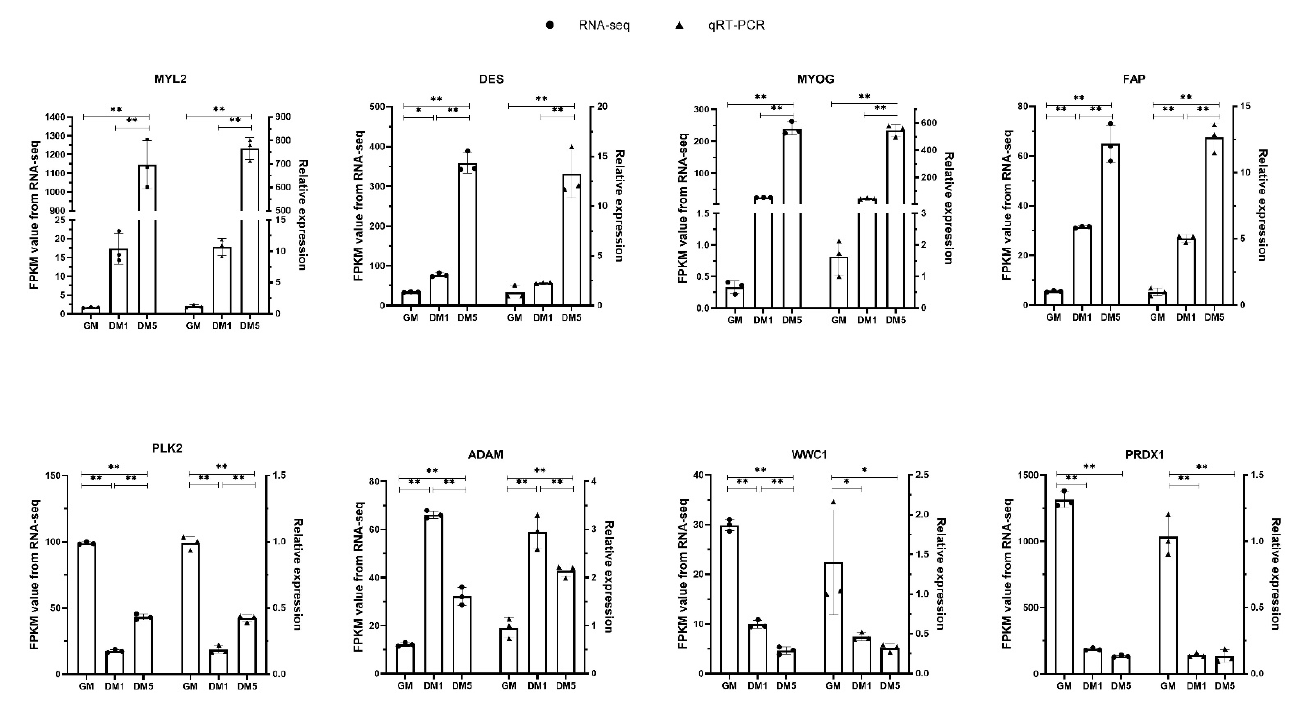
Figure 7 . The validation of eight DEGs by qRT-PCR. “*” was considered a significant difference ( p < 0.05); “**” was considered a highly significant difference ( p < 0.01). ( p < 0.05); “**” was considered a highly significant difference ( p <